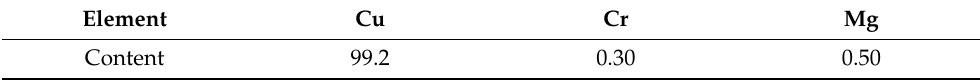
Table 1. Chemical composition of the Cu–Cr–Mg alloy powder